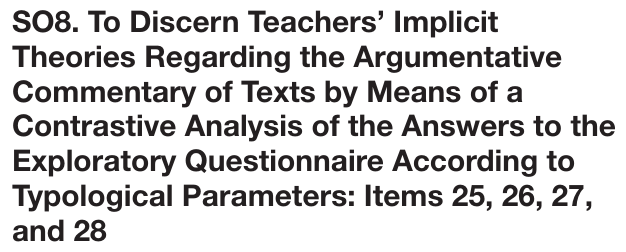
those who agree with question 27 to disagree with question